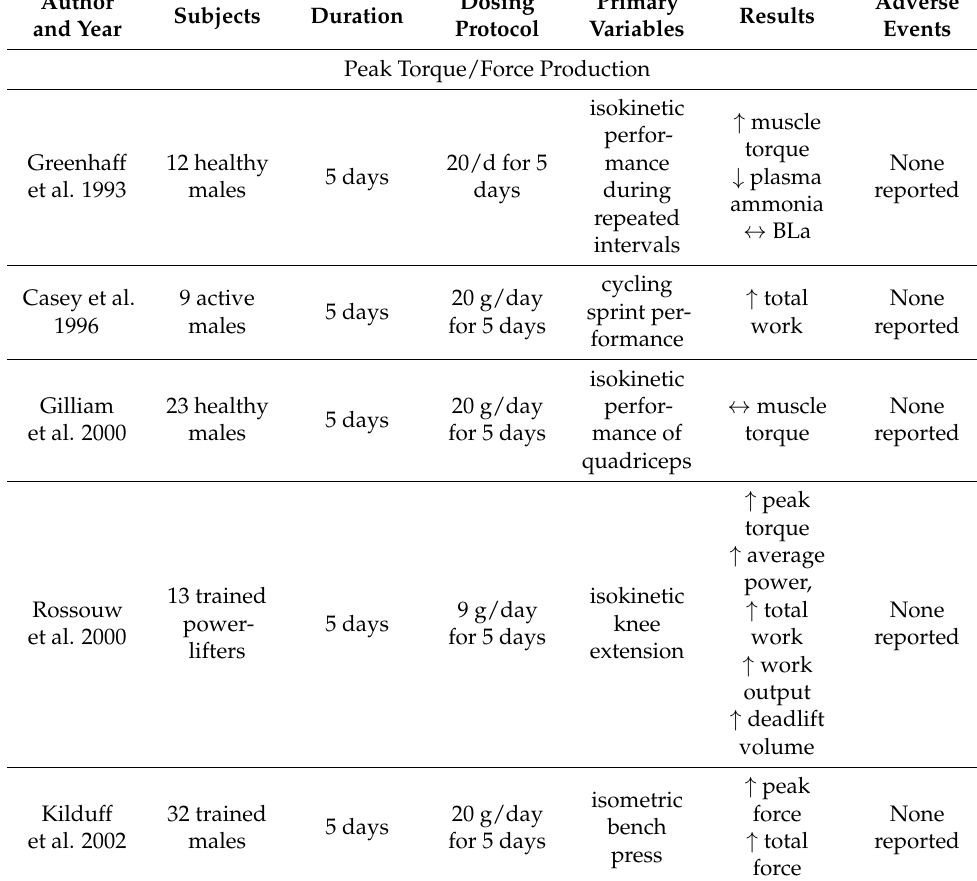
Table 3. Summary of selected studies examining the acute effects of creatine monohydrate on strength